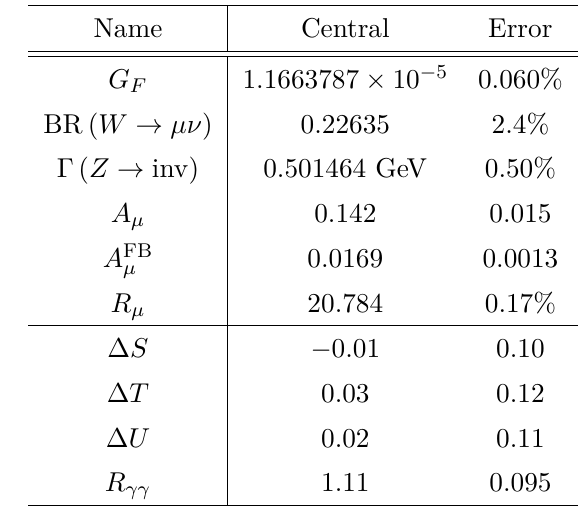
Table 8 . Summary of the constraints from the electroweak precision measurements [72] we apply here. The errors with % are relative